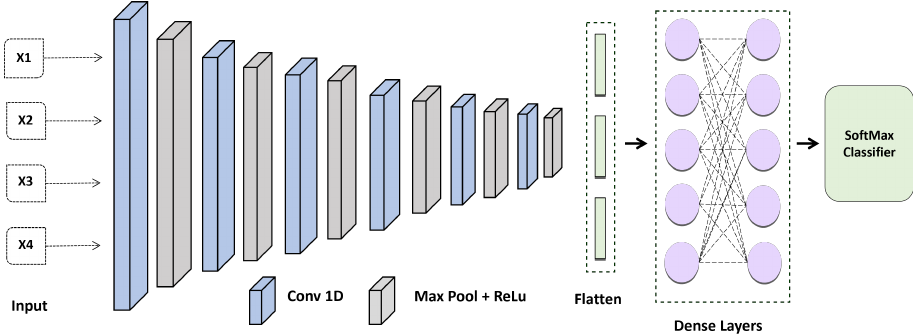
Figure 4. Proposed Convolution Neural Network Model for ECG-based